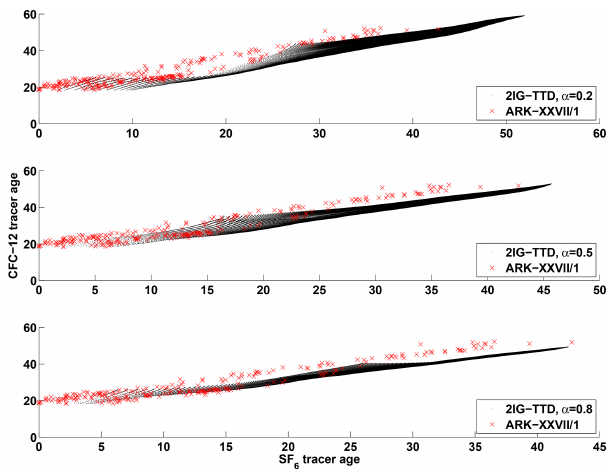
Figure 6. Validity areas of linear combinations of two IG-TTDs for α = 0 . 2, 0.5, 0.8, (cid:49) 1 /(cid:48) 1 = 1 . 4, (cid:49) 2 /(cid:48) 2 = 0 . 6 and (cid:48) 1 , 2 = 1–500 (black dots). The field data are described by the red crosses. The lower the α value, the higher the share of the diffusively dominated IG-TTD.